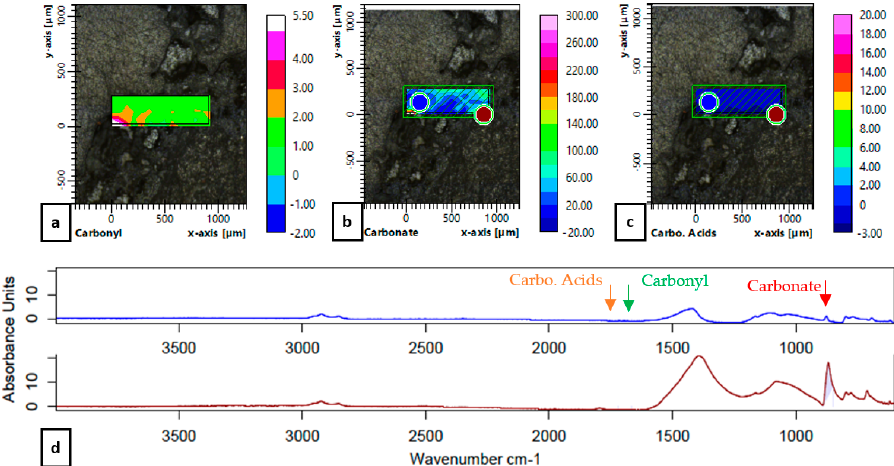
Figure 11. Chemical imaging of the MRAB sample (Area 4): carbonyl group ( a ); carbonate group ( b ); carboxylic acids ( c ); spectral visualization of the selected points marked by colored dots in Figure 11b,c ( d ).